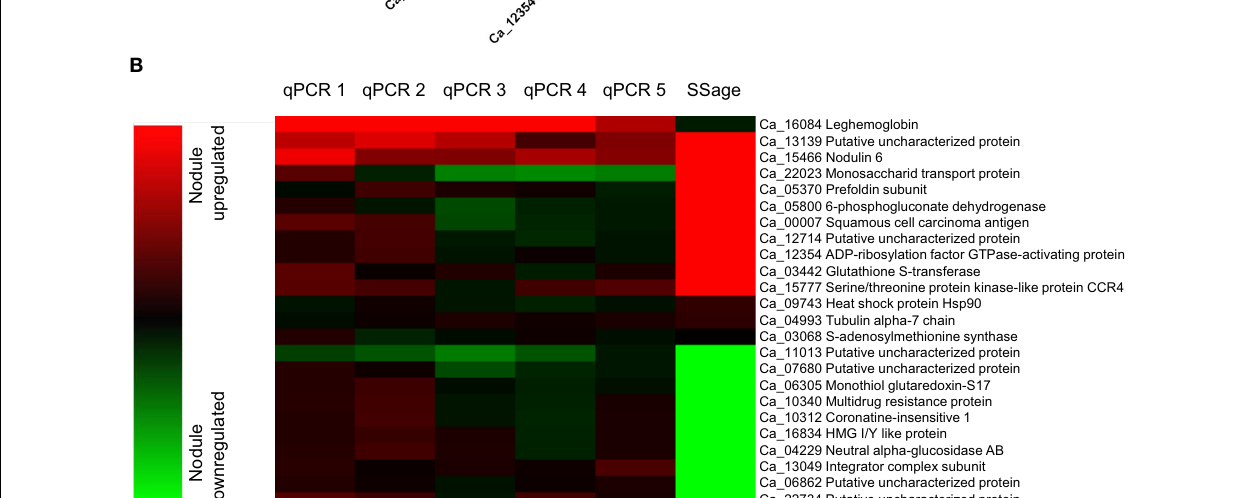
values mRNAs that are more abundant in root tissue. The gene expression ratios of the individual biological replicates (qPCR1-5) in comparison to the pooled (SSage) tissues are additionally shown in the heat map. Nodule upregulated transcripts are represented in red and downregulated transcripts in green. Clustering was performed with the MultiExperiment Viewer version 4.9 by hierarchical clustering of all genes and samples using Euclidean distance